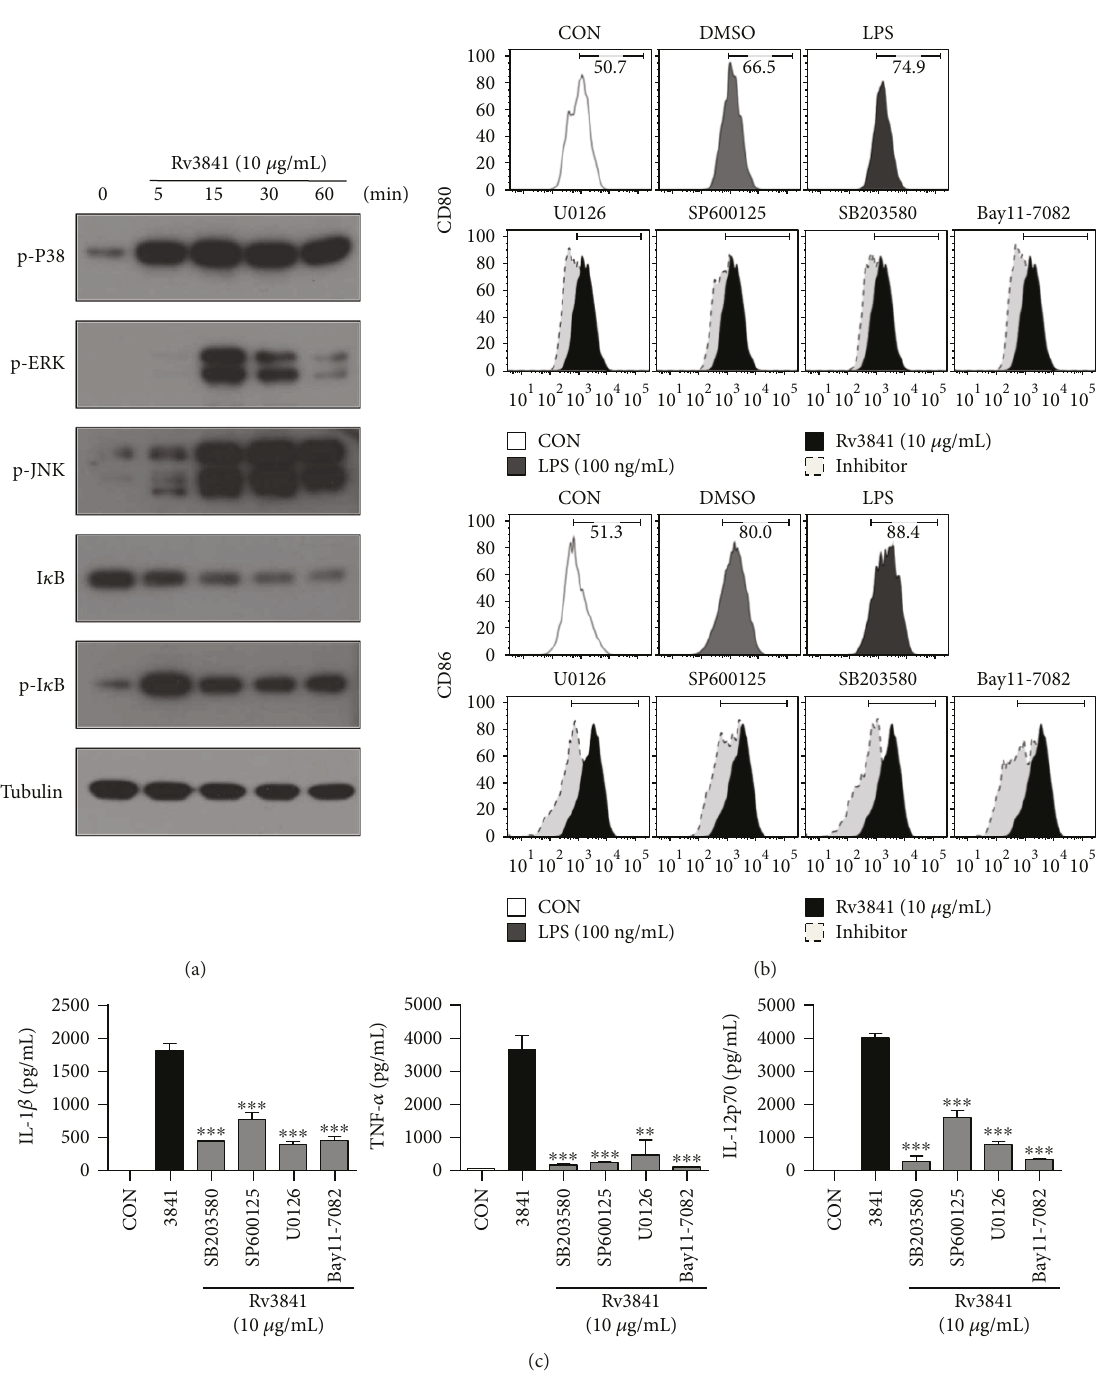
Figure 2: DC maturation triggered by Rv3841 involves activation of MAPKs and NF- κ B. (a) Protein production over time by DCs treated with 10 μ g/mL Rv3841. Cell lysates were subjected to SDS-PAGE, and immunoblotting analysis was carried out by means of antibodies speci fi c to phospho-p38 (p-p38), p-ERK1/2, p-JNK, p-I κ B- α , and I κ B- α . α -Tubulin served as the loading control for the cytosolic proteins. Representative blots from fi ve independent experiments are shown. (b, c) DCs were treated with pharmacological inhibitors of p38 (SB203580, 20 μ M), ERK1/2 (U0126, 10 μ M), JNK (SP600125, 20 μ M), or NF- κ B (Bay 11-7082, 20 μ M) or with DMSO (vehicle control) for 1h prior to treatment with 10 μ g/mL Rv3841 for 24h. (b) The expression of costimulatory molecules was determined by fl ow cytometry. (c) The concentrations of TNF- α , IL-1 β , and IL-12p70 in the culture media were determined by ELISAs. Mean values ± SD ( n = 3 ) are shown; ∗∗ p < 0 01 or ∗∗∗ p < 0 001 : a signi fi cant di ff erence from Rv3841-treated DCs, as determined by unpaired Student ’ s t